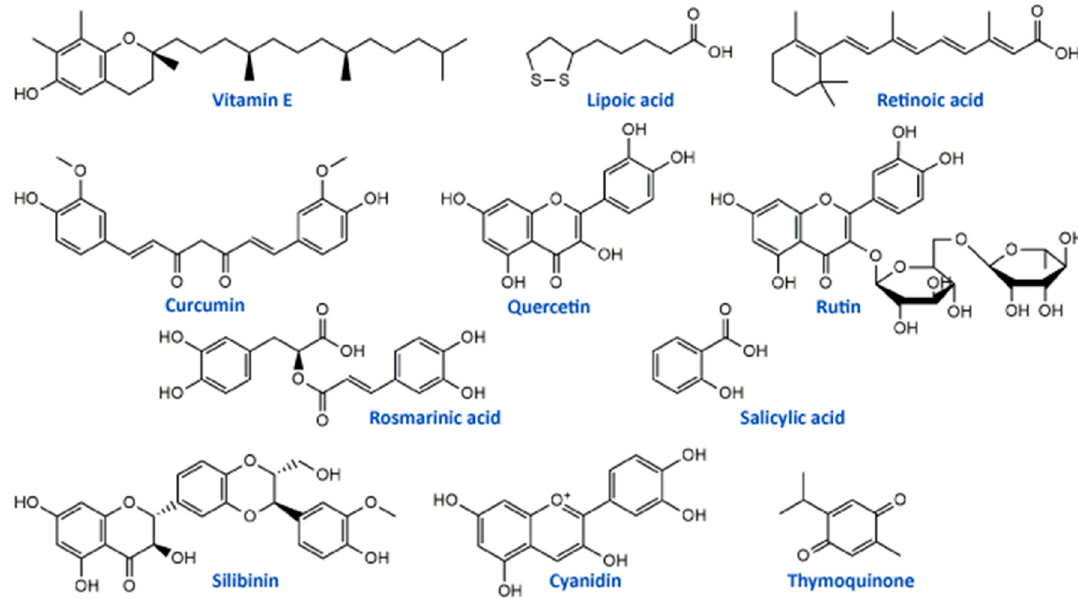
Figure 2. Chemical structures of some supplements and natural antioxidants (from Tables 2 and 3) that exhibited neuroprotective potential against platinum drugs-induced neurotoxicities.